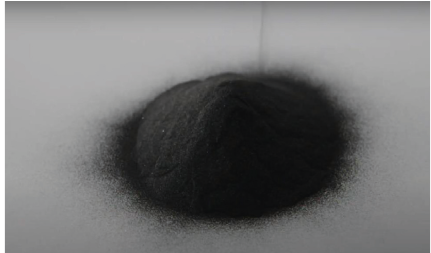
Figure 1: Image of B